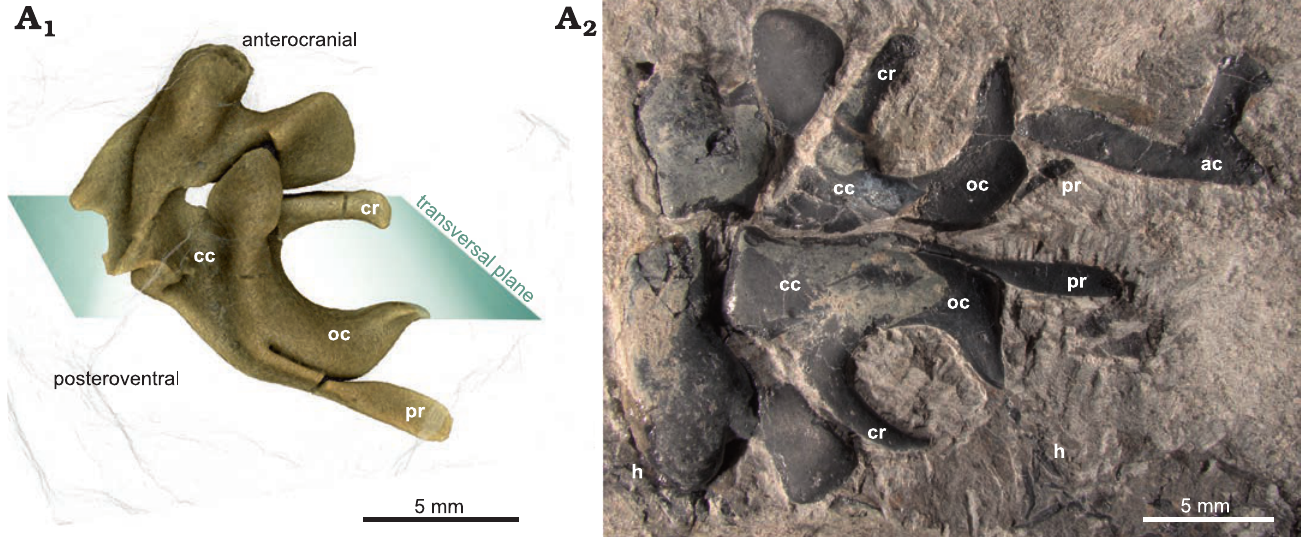
Fig. 2. Fossil belemnoid cartilage of Phragmoteuthis bisinuata (Bronn, 1859), NHMW 2021/0123/0057, from the Carnian (Upper Triassic) of Polzberg, Northern Calcareous Alps in Austria. Open rings are medially connected determined as the ocular cartilage, wing-like extensions correspond to the arm cartilage. Abbreviations: ac, arm cartilage; cc, cephalic cartilage; cr, carrier; h, hooks; oc, ocular cartilage; pr, processus. Figure adapted after fig. 3 in Lukeneder and Lukeneder